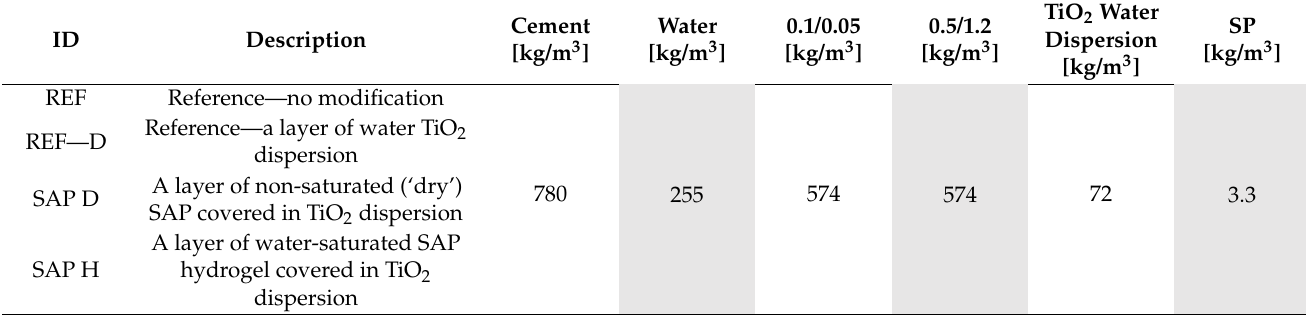
Table 2. Composition of the prepared mortar and information regarding the type of applied surface modification for each series of